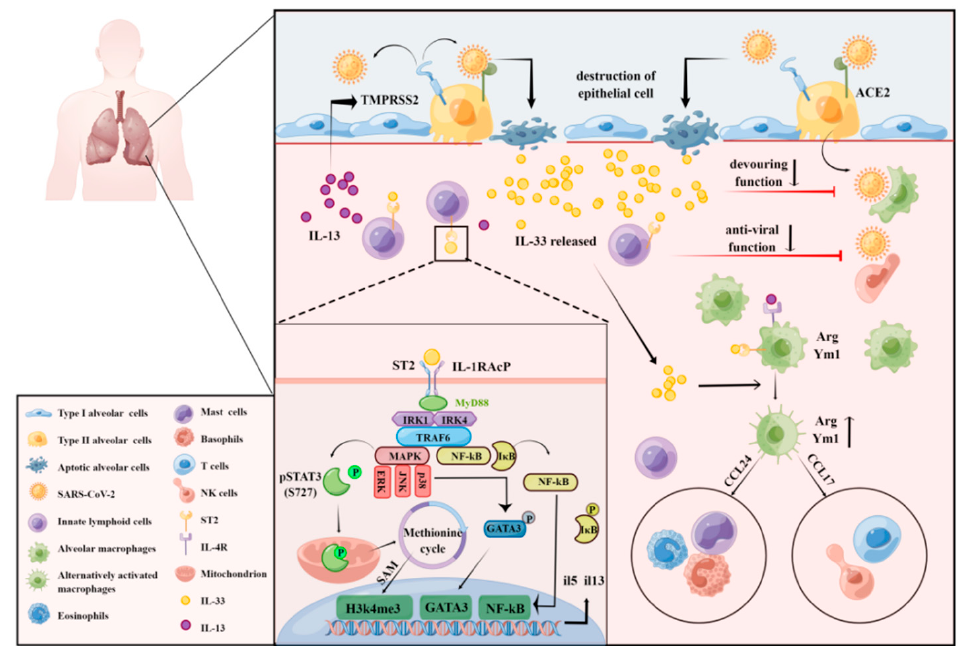
Figure 3. Potential mechanisms by which IL-33 regulates ILC2 and macrophages in COVID-19. SAS-CoV-2 infects cells via ACE2 on the surface of type II alveolar epithelial cells with the assistance of TMPRSS2. IL-33 acts as an alarmin in response to viral infection and is secreted in large quantities by apoptotic alveolar epithelial cells. The released IL-33 acts on the specific receptor of ST2L on the surface of the ILC2 membrane and recruits its accessory receptor IL-1RAcP to form the functional IL-33 receptor complex. Following binding of IL-33 to IL-1RAcP, the receptor complex is activated by exposure of the TIR domain of IL-1RAcP and recruitment of myeloid differentiation primary response gene 88 (MyD88) into the heterodimeric IL-33R1 complex. Recruitment of MyD88 results in the recruitment of IL-1 receptor-associated kinase 1 (IRAK1) and IRAK4 through their death domains. This complex then activates downstream signaling pathways, including mitogen-activated protein kinases MAPK (such as ERK, JNK, p38), GATA3, and NF- κ B, and enhances cellular respiration and ATP production, which induces an elevated level of the histone modification H3K4me3. Activation of NF- κ B, GATA3, and H3K4me3 in the nuclear membrane further promotes the production of inflammatory cytokines, such as IL-5 and IL-13, and enhances viral recruitment by TMPRSS2. On the other hand, the release of IL-33 directly reduces phagocytosis by macrophages and the antiviral effects of NK cells. In contrast, IL-33 and IL-13 bind to ST2L and IL-4R, respectively, on the surface of macrophage membranes, thereby promoting the activation of macrophage differentiation toward AAMs and damage to alveolar